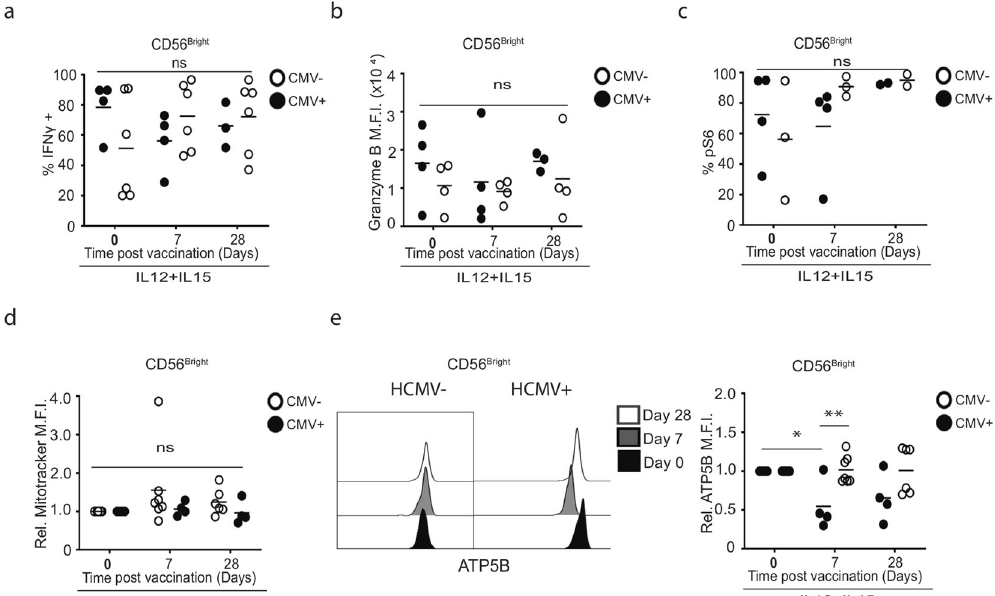
Fig. 5 Prior CMV infection impacts ATP synthase expression in CD56 bright NK cells in response to vaccination. a Summaries of IL-12 (30 ng)/IL-15 (100 ng) stimulated IFN γ + , b granzyme B expression and c pS6 + CD56 bright NK cells in vaccine recipients strati fi ed by HCMV serostatus at pre- and post-vaccination timepoints (Days 7 and 28). (HCMV – , n = 6 for a , b , n = 3 for c , HCMV + , n = 4). Representative histograms and summaries of post-vaccination relative fl uorescence intensity of d Mitotracker CMXRos and e ATP5B in NK cells from HCMV sero-discordant donors normalised to baseline (Day 0) values ( n = 7 HCMV − , n = 4 HCMV + ). Samples were compared by two-way ANOVA with Sidek ’ s post hoc test. n.s. not signi fi cant, * p < 0.05, ** p <